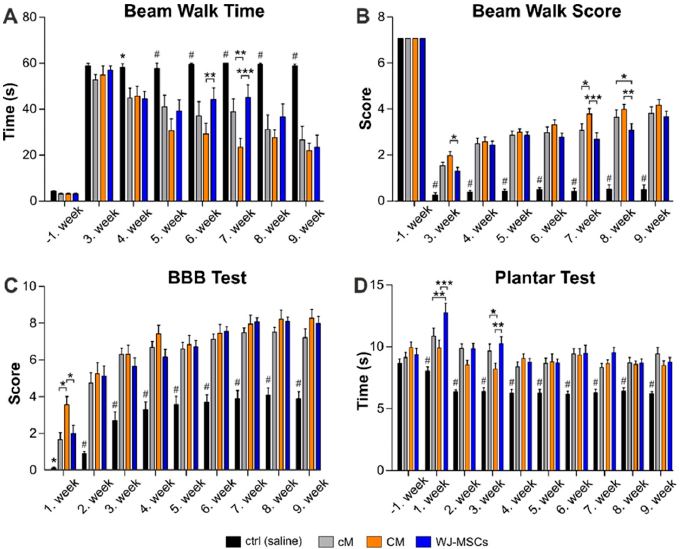
Figure 3. Results of behavioral testing. The locomotor and sensory function of animals were tested by